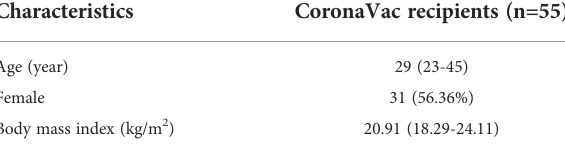
TABLE 1 Baseline characteristics of vaccine